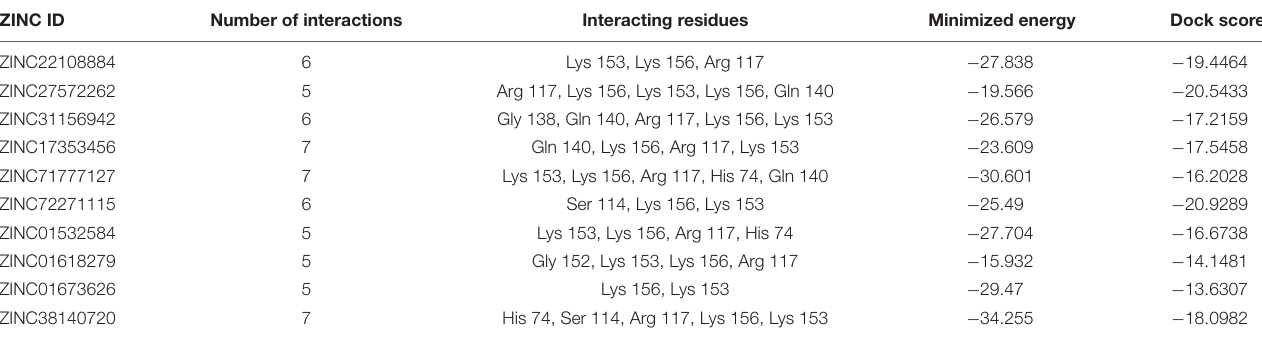
FIGURE 13 | Interaction of ribosome-binding factor A with ZINC01235906 (colored in red). The interacting residues (green) are shown making bonding (dotted lines) with the ligand. TABLE 16 | DNA-binding response regulator and its interaction profile with docked compounds, their ZINC ID, minimized energy, number of interactions, dock score, and interactive